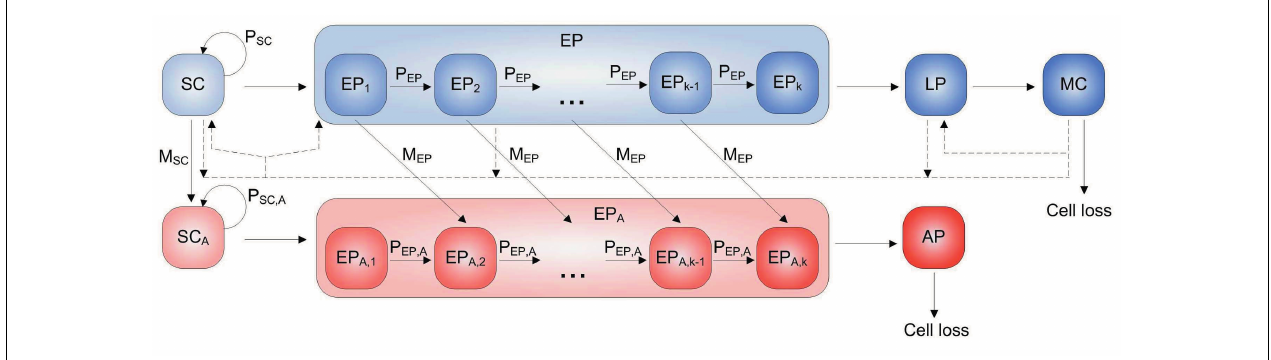
FIGURE 1 |A diagram for multi-compartment blocks shown to derive a system of ordinary differential Eq.(1; Ganguly and Puri, 2006; Piotrowska et al., 2008). The EP cells and EP A cells are each split into K sub-compartments that contain an identical type of cells, which differ only in